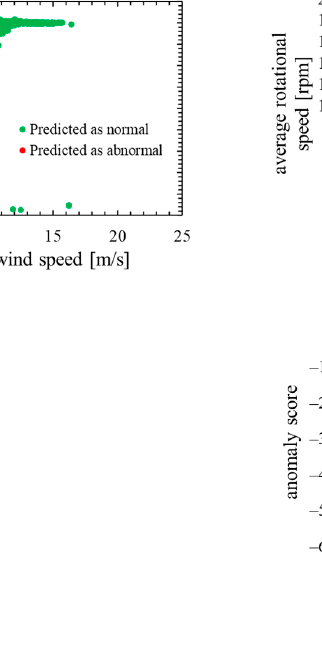
Figure 16. Training data of the model in which the number of mixture components K was 256 (threshold is 100th percentile’s value): ( a ) wind speed rotational speed characteristic; ( b ) time characteristics of rotational speed; ( c ) time characteristics of anomaly score.